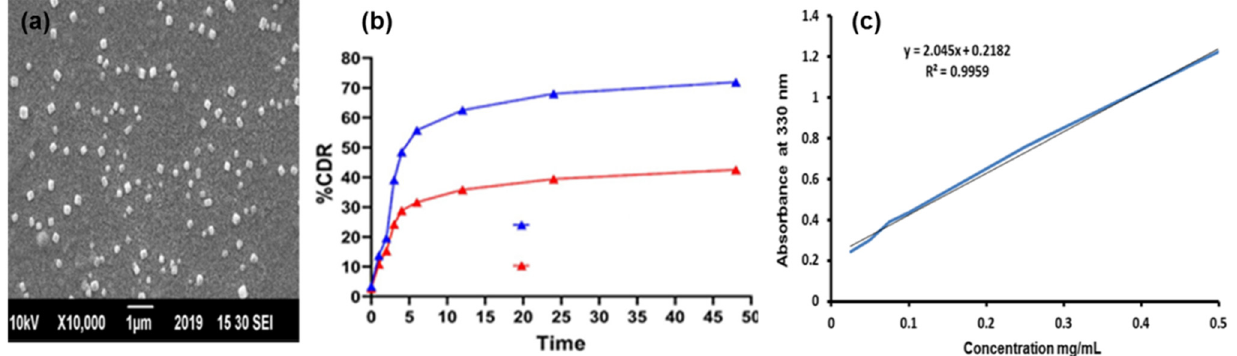
Figure 3. ( a ) SEM Image of vitexin liposomes (VLPs) and ( b ) Cumulative drug release from VLPs and polyethylene glycol coated vitexin liposomes (PEG-VLPs) ( c ) Standard